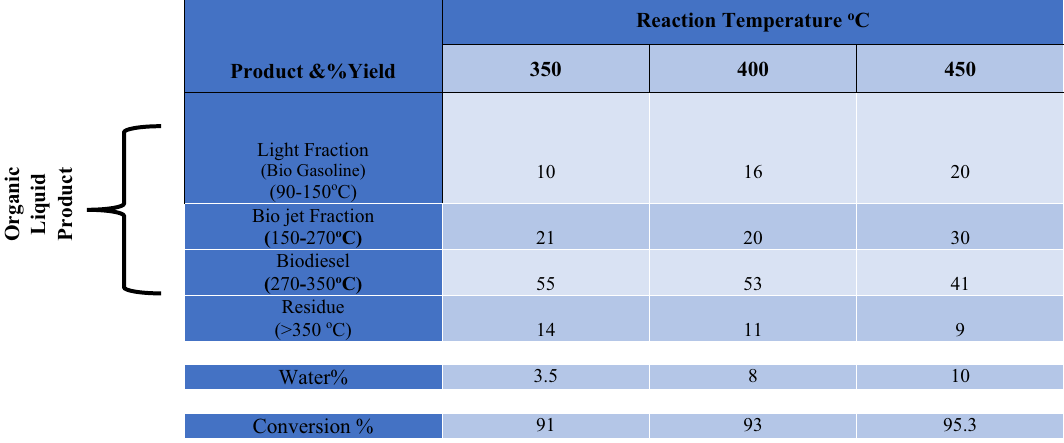
Table 3. Effect of Reaction Temperature on Hydro-conversion of WCO over CoAl 2 O 4 Nanoparticles. (Pressure 50 bar, LHSV: 1 h -1 ).